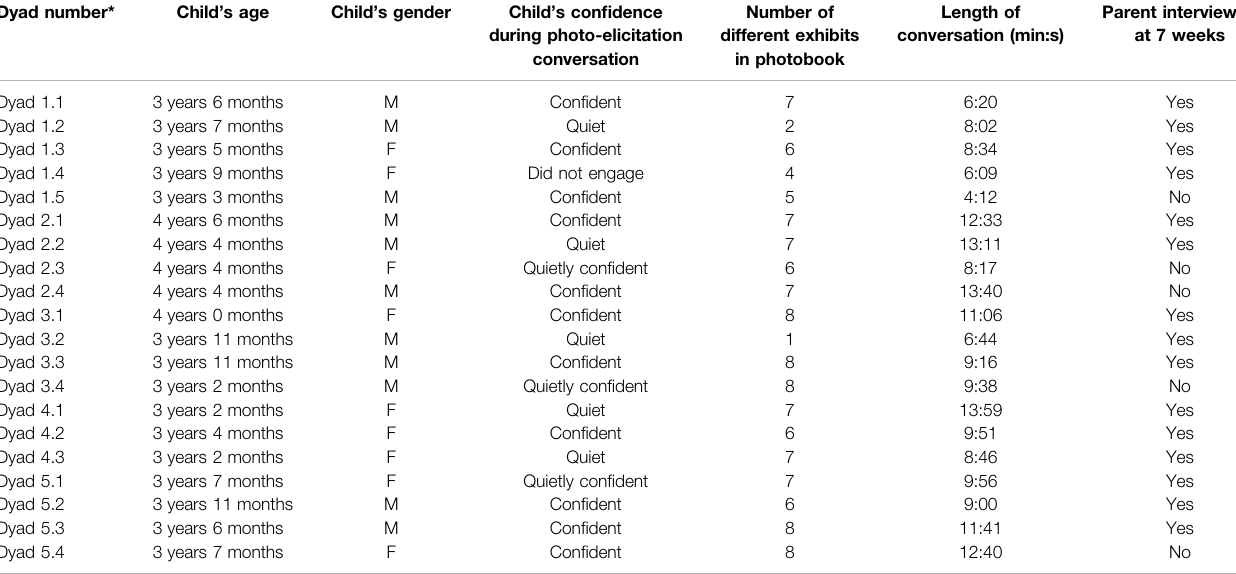
TABLE 2 | Description of child/parent dyads in photo-elicitation process. Dyad number* Child ’ s age Child ’ s gender Child ’ s con fi dence